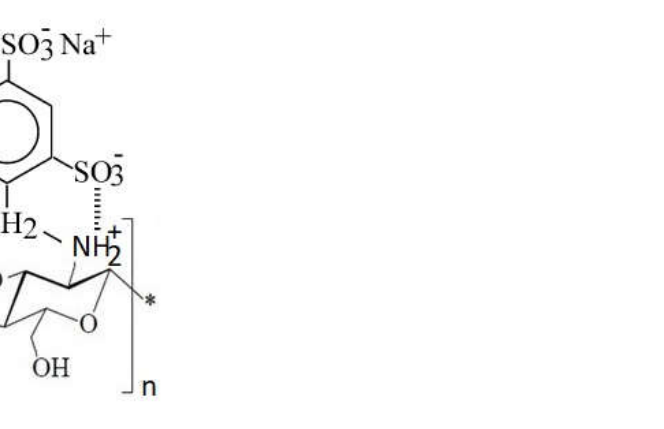
Anticoagulant properties of sulfated chitosan derivatives are attributed to the inter-